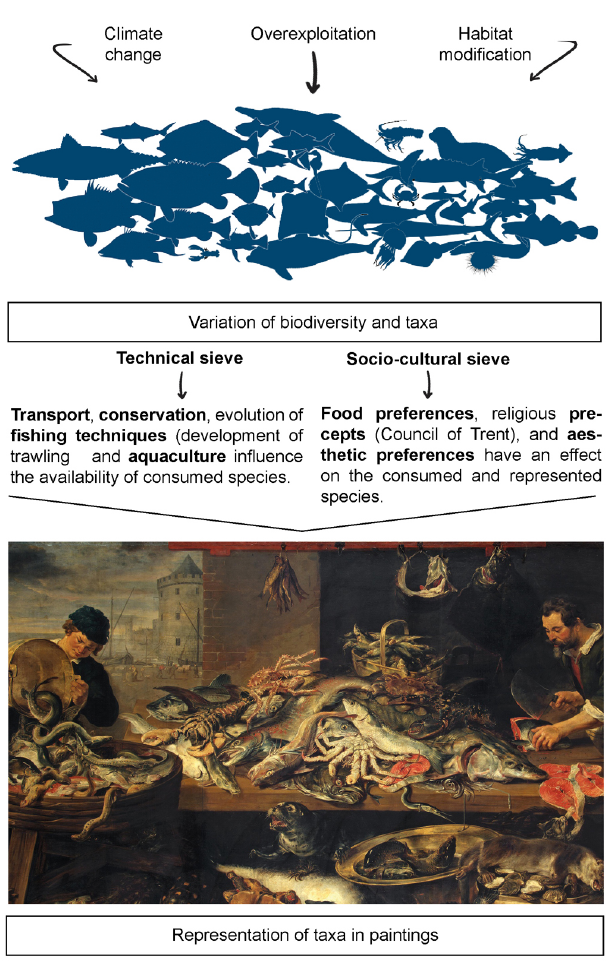
Fig. 1 . Main selection sieves of species represented in paintings. Painting: Snyders, Frans. Fish Market. Flanders, between 1618 and 1621. Oil on canvas. Image is used from